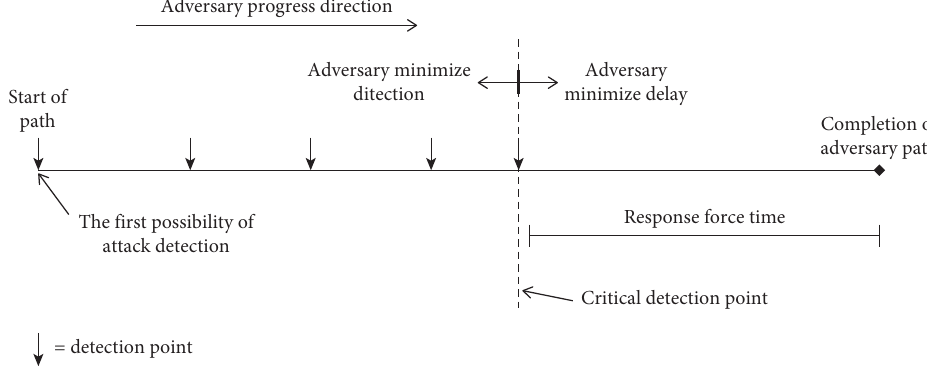
Figure 8: Tradeoff between ADT and RFT and critical detection point